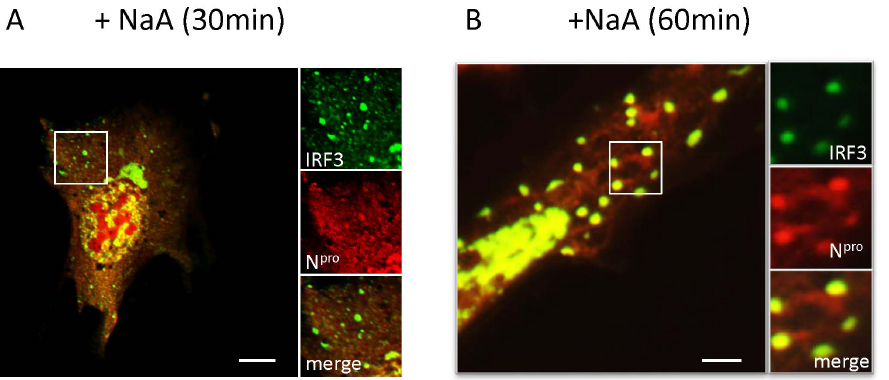
Figure 3. N pro rapidly redistributes with IRF3 to mitochondria and cytoplasmic puncta following induction of stress. (A). MEF cells co-expressing N pro -cherry (red) and IRF3-GFP (green) were treated with sodium arsenate ( + NaA) for 30 minutes and examined by confocal microscopy. (B). Treatment of MEF cells co-expressing N pro -cherry and IRF3-GFP for 60 minutes.